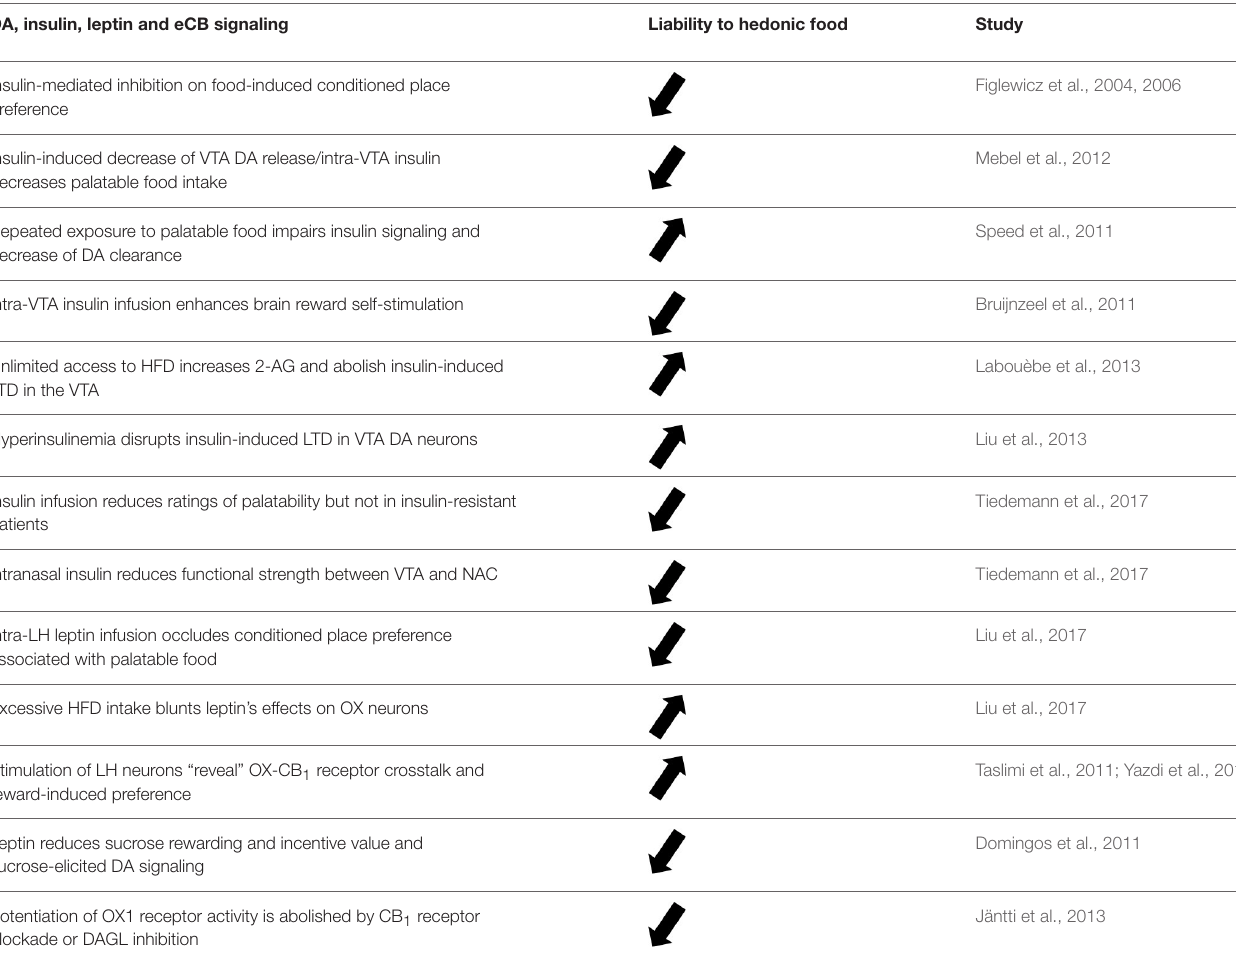
TABLE 3 | Selected studies showing the crosstalk between DA, insulin, leptin and eCB signaling. DA, insulin, leptin and eCB